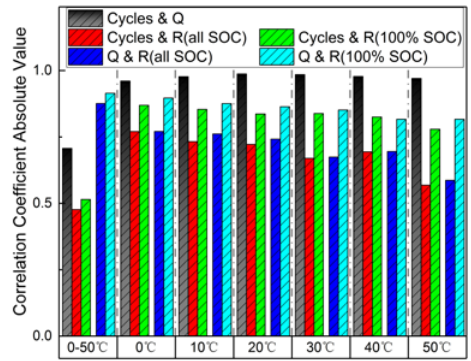
Figure 5. Correlation relationship for batteries.